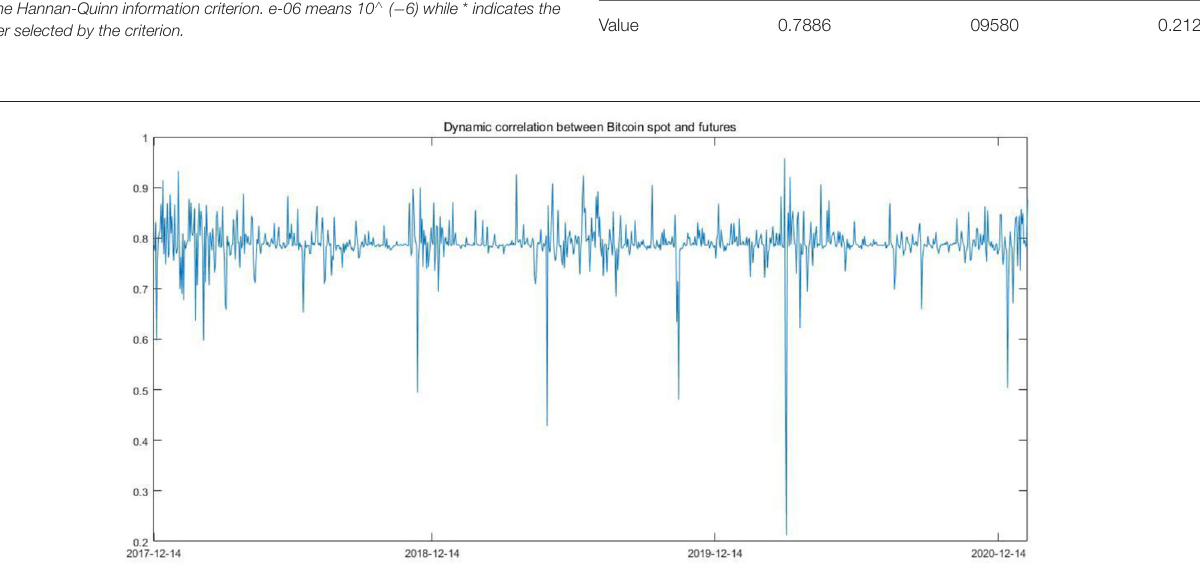
FIGURE 4 | Dynamic correlation between Bitcoin spot and